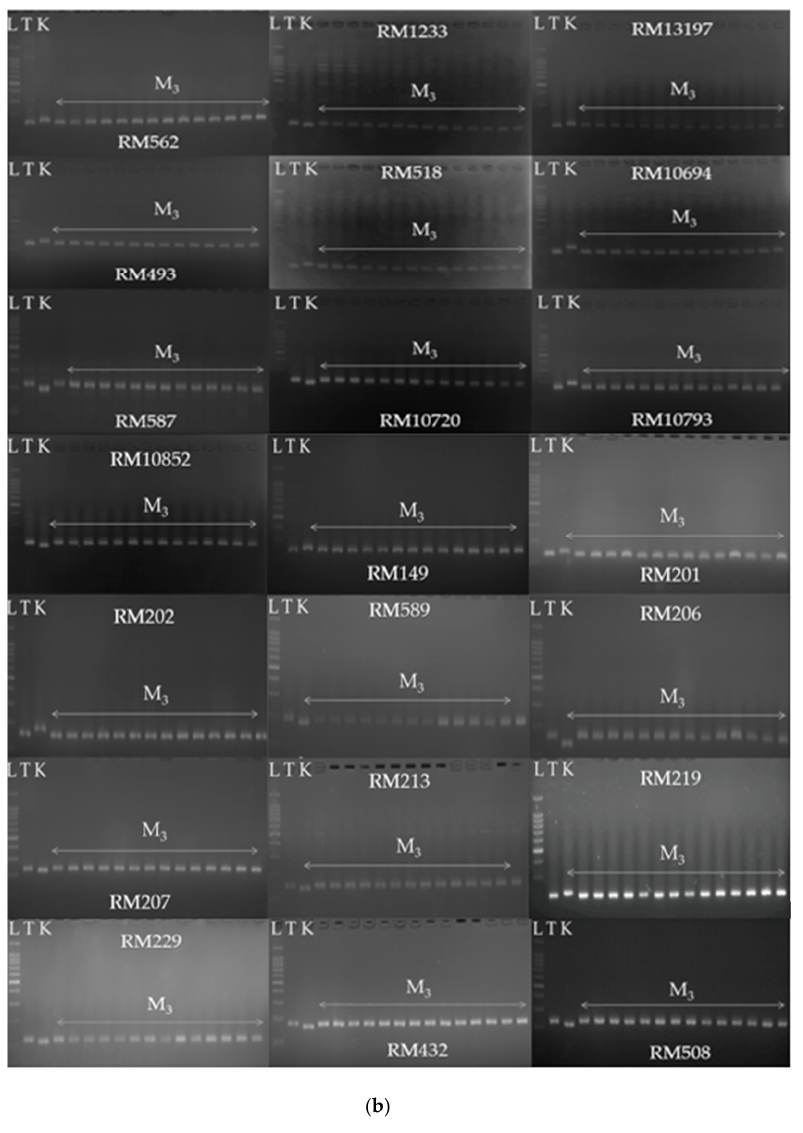
Figure 3. ( a ) PCR products of M 2 population by SSR markers RM562, RM1233, RM13197,